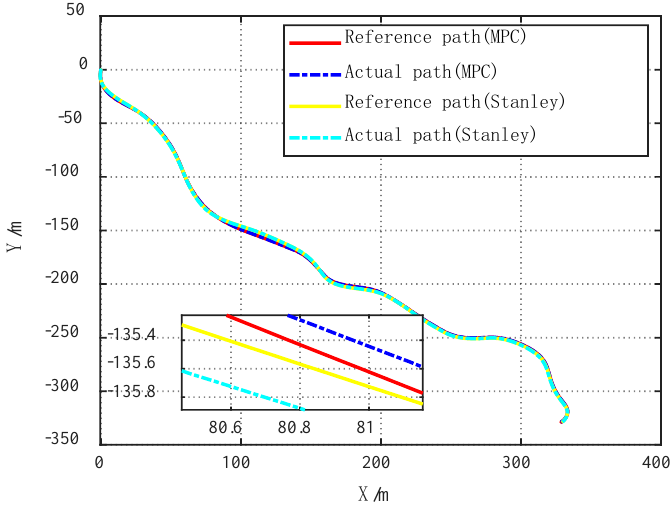
Figure 16. Global trajectory of MPC control and Stanley control. It can be seen from the above test results that under the complex working conditions of the “C” shape and “S” shape reference path, the MPC control algorithm has a significantly improved control effect on the lateral deviation than the Stanley algorithm, and the control effect on the heading angle deviation is comparable. Under the “C” shape reference path, the maximum lateral deviation is reduced from 0.55 m to 0.08 m, and the average lateral deviation is reduced from 0.19 m to 0.02 m, and under the “S” shape reference path, the maximum lateral deviation is reduced from 0.4 m to 0.16 m, the average lateral deviation was reduced from 0.12 m to 0.05